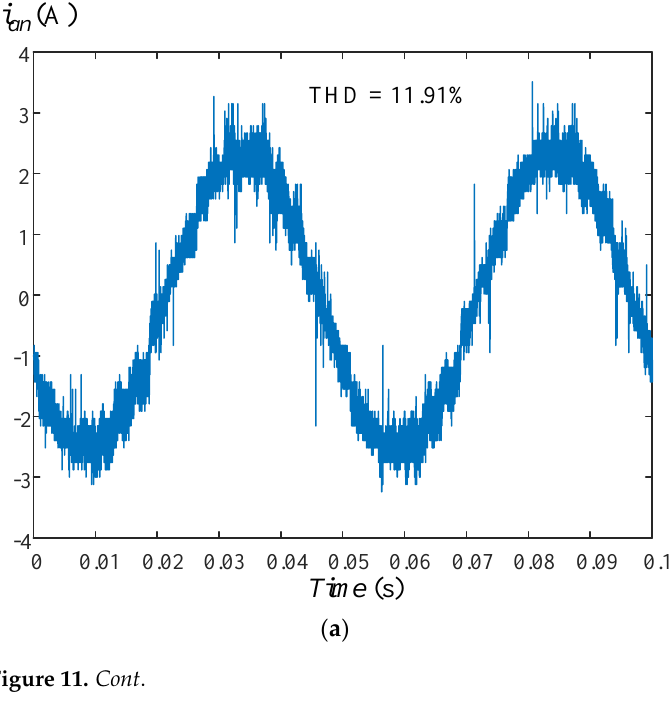
Figure 10. Measured input waveforms ( a ) i AN without filter, ( b ) THD without filter, ( c ) i AN with method 1. ( d ) THD method 1, ( e ) i AN with method 2, ( f ) THD with method 2.